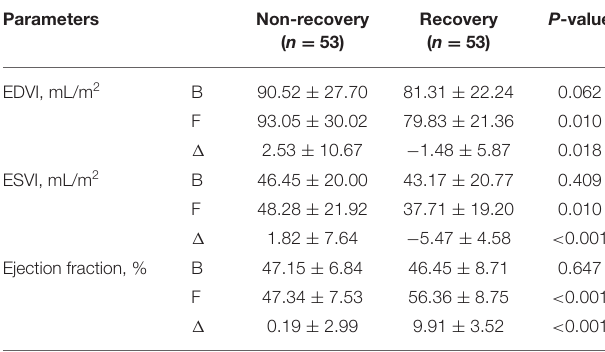
TABLE 2 | Changes in left ventricular volume and ejection fraction during follow-up.